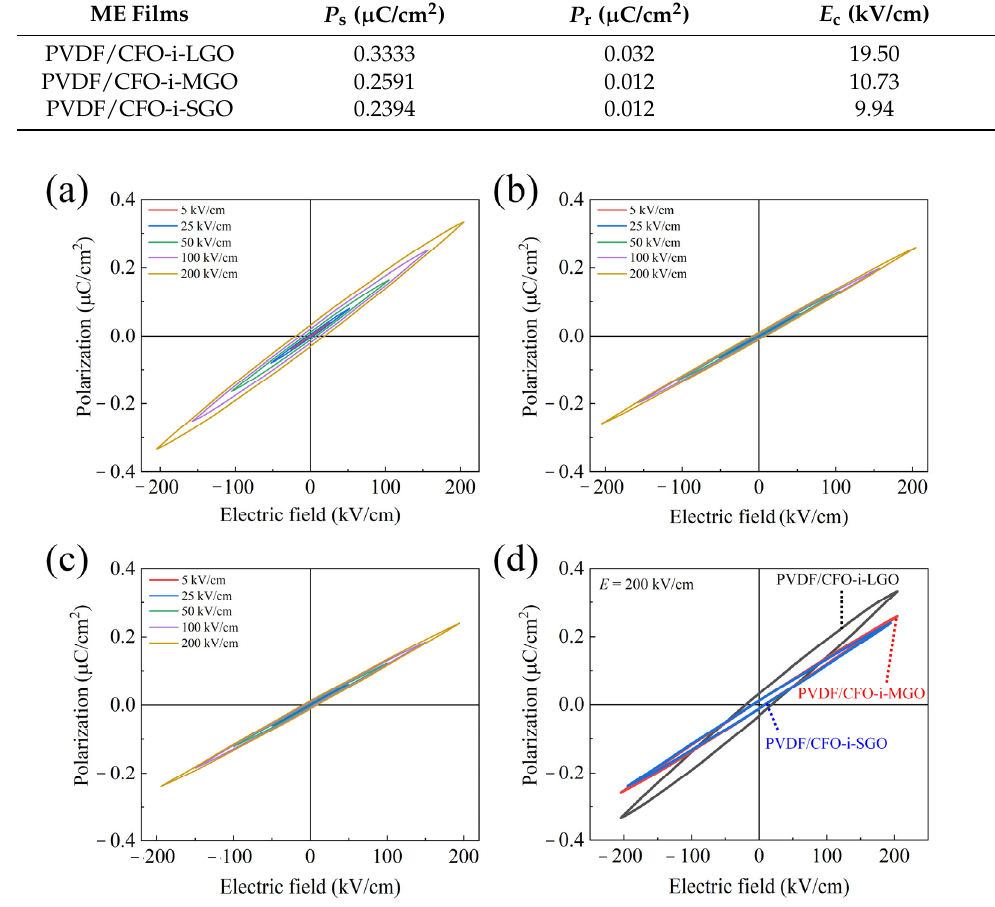
Figure 9. P-E hysteretic curves of the 3-2 type ME films of ( a ) PVDF/CFO-i-LGO, ( b ) PVDF/CFO-i- MGO, and ( c ) PVDF/CFO-i-SGO, and ( d ) P-E comparison under an applied electric field of 200 kV/cm.